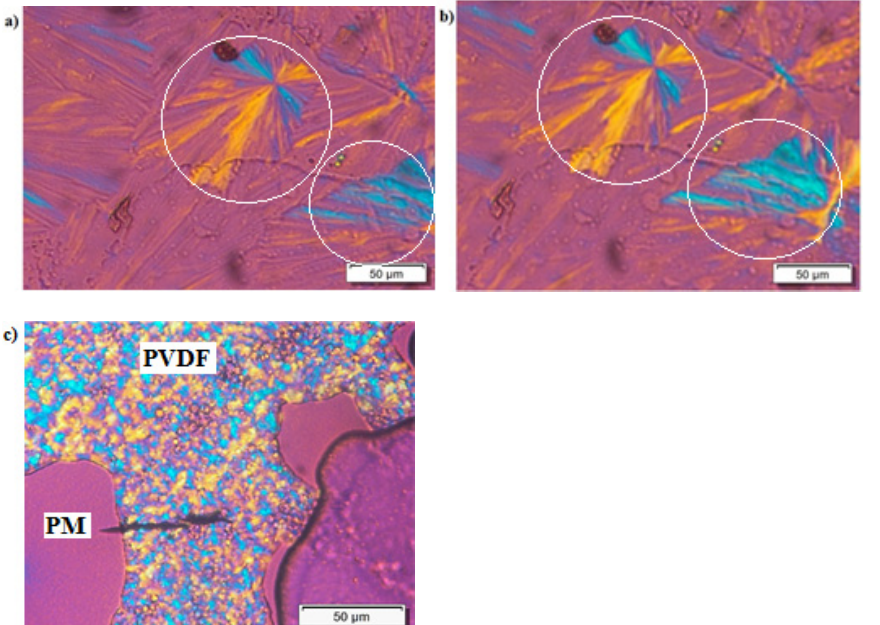
Figure 2. PLOM images of ( a ) PVDF block spherulites in the PM 38 - b -PVDF 62 diblock copolymer sample after having been cooled at 20 °C/min to a T = 130 °C and ( b ) crystallization of the PM block in the PM 38 - b -PVDF 62 sample after having been cooled at 20 °C/min to T = 25 °C. ( c ) Evident phase segregation of the PVDF and PM phases in a PM 23 PVDF 77 blend sample after a cooling process at 20 °C/min down to T = 25 °C.